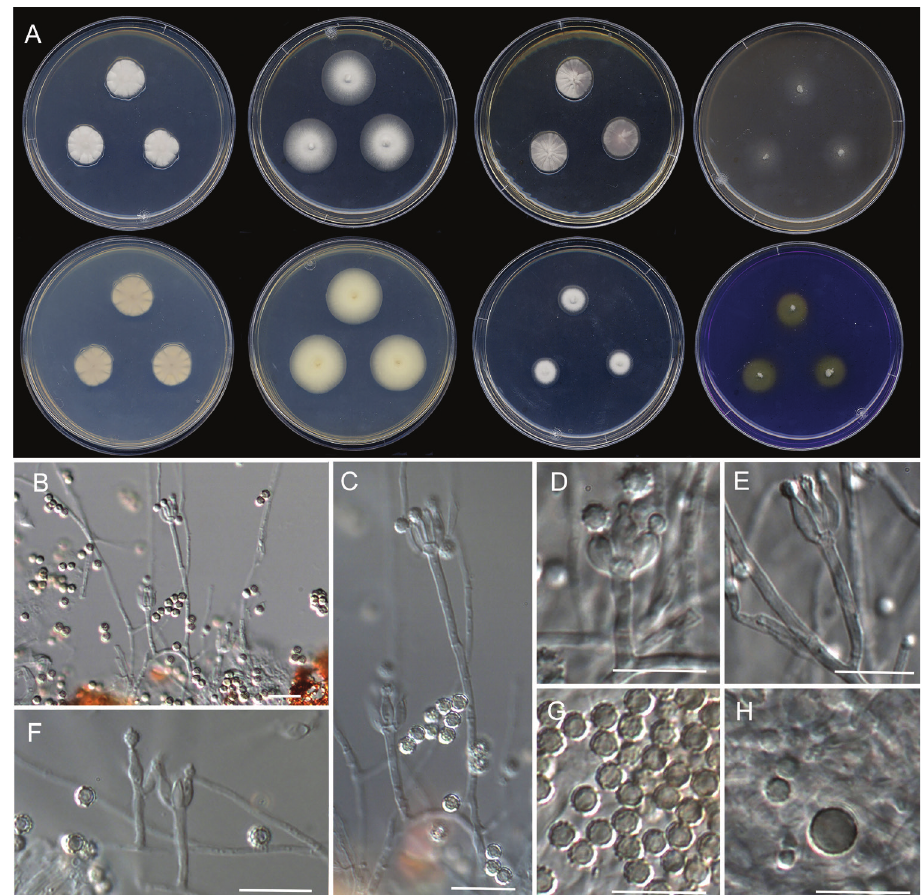
Figure 11. Morphological characters of Penicillium heteromorphum (FMR 18043). A colonies from left to right (top row) CYA, MEA, YES, and OA; (bottom row) CYA reverse, MEA reverse, DG18, and CREA B, C, F conidiophores on OA. D, E conidiophores on Czapek’s Agar G–H conidia. Scale Bars: 25 μm ( B ), 10 μm ( C–H